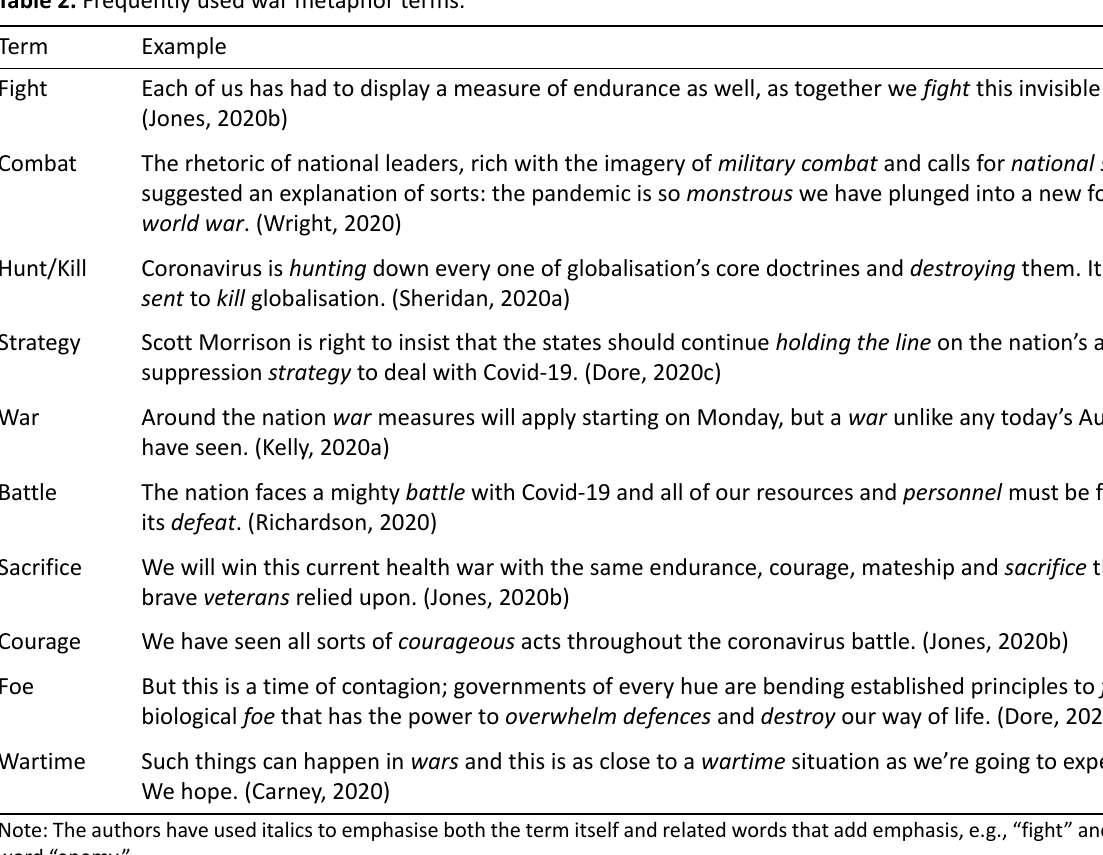
Table 2. Frequently used war metaphor